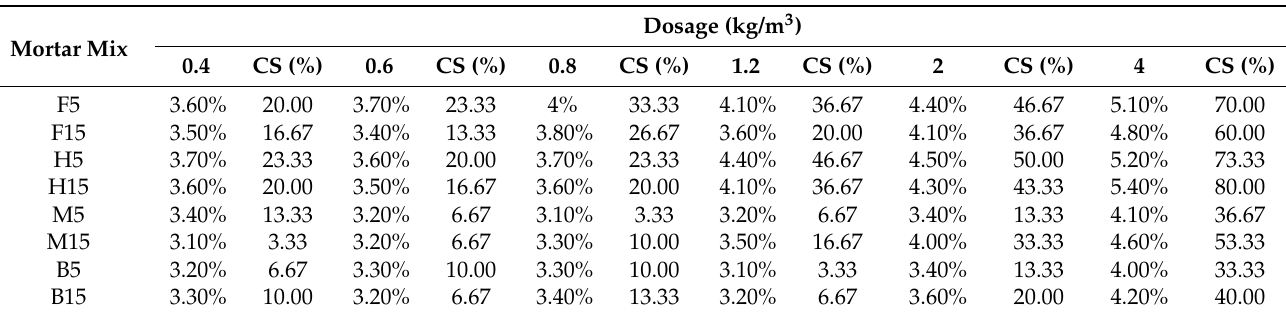
Table 8. Air trapped (%) mean value measured on three specimens for each mortar mix. CS: Control sample—Air trapped range respect CS; Air trapped CS: